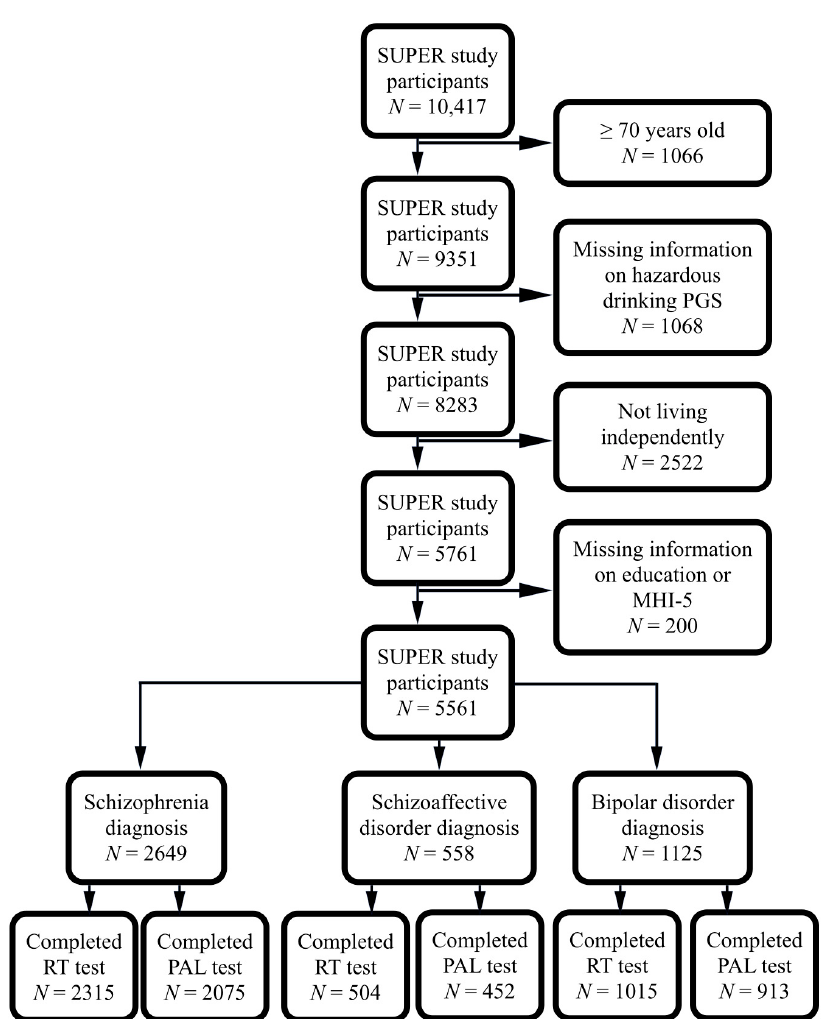
Figure 1. Flowchart showing the selected study populations. SUPER, Suomalainen psykoosisairauk- sien perinnöllisyysmekanismien tutkimus; MHI-5, Mental Health Inventory-5; RT, Reaction Time; PAL, Paired Associative Learning.